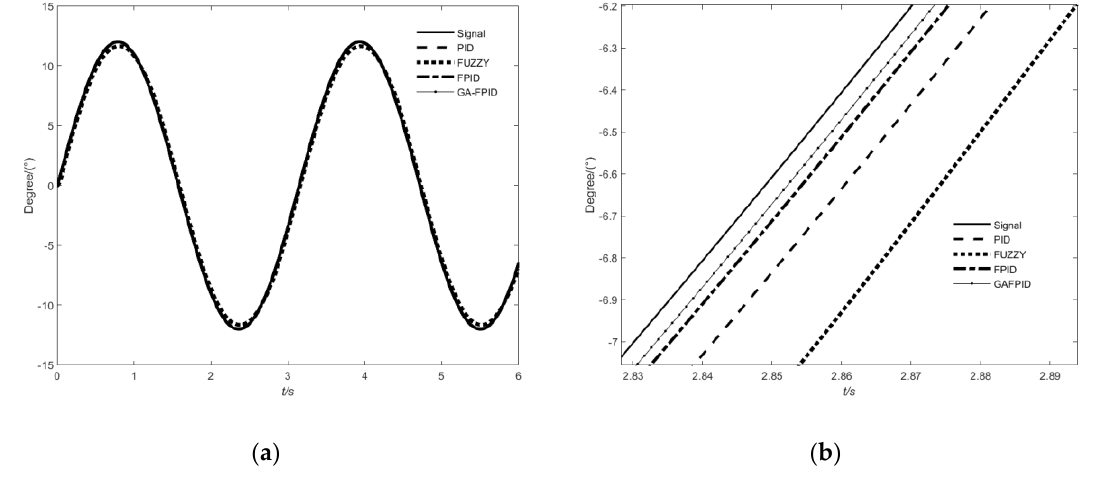
Figure 11. Sinusoidal input signal at 2 Hz: ( a ) tracking response; ( b ) local enlarged view. Table 5. Simulation data of the frequency response under loading.